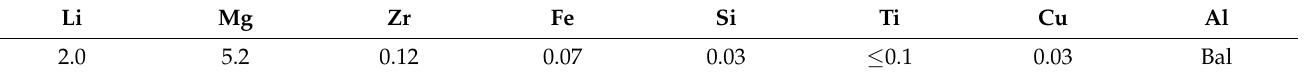
Table 1. Chemical composition of the 1420 Al-Li alloy (wt.%).